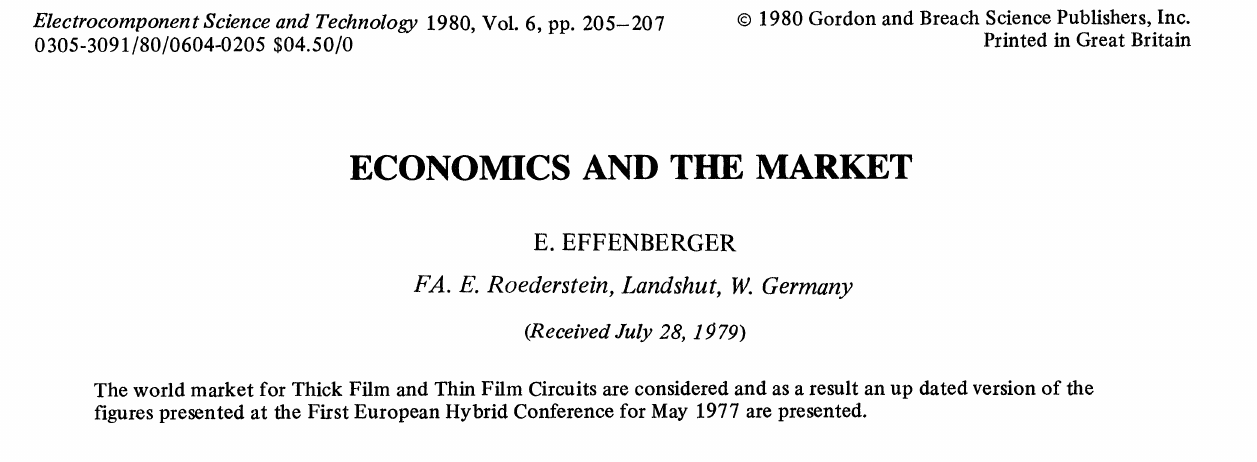
TABLE II Open market for thick and thinfilm circuits in Europe 1979: